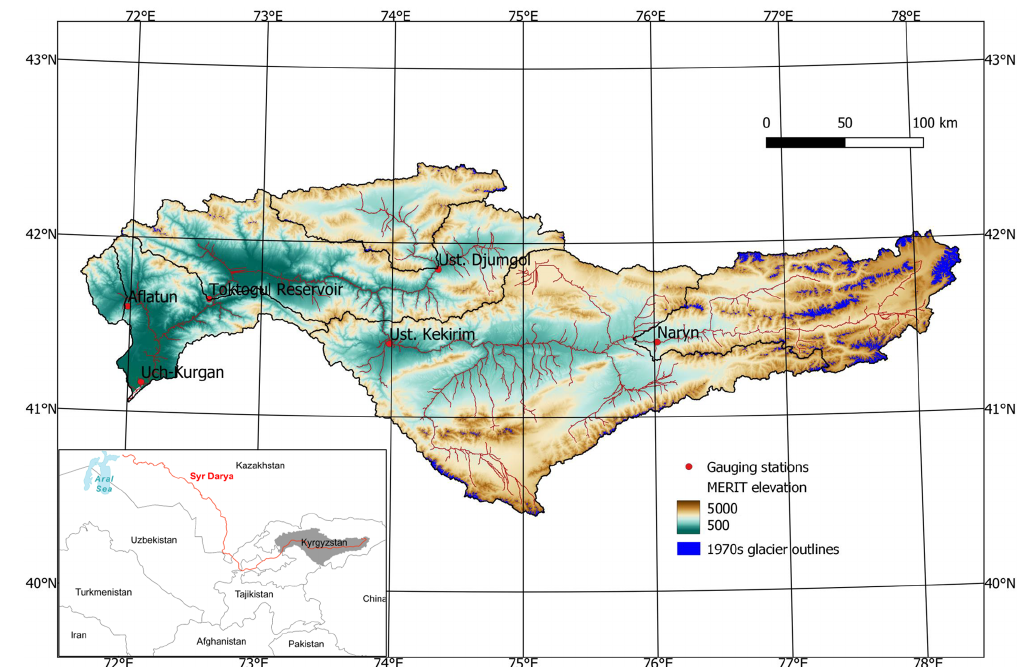
Figure 1. The location of Naryn catchment and gauging stations. The MERIT DEM elevation and 1970s Landsat-derived glacier outlines used in this study are also displayed. The sub-catchment boundaries (black) and river path (red) calculated using DECIPHeR are shown. The Naryn River is a tributary of the Syr Darya River which flows across central Asia from the Tien Shan mountains to the remains of the Aral Sea (bottom left inset